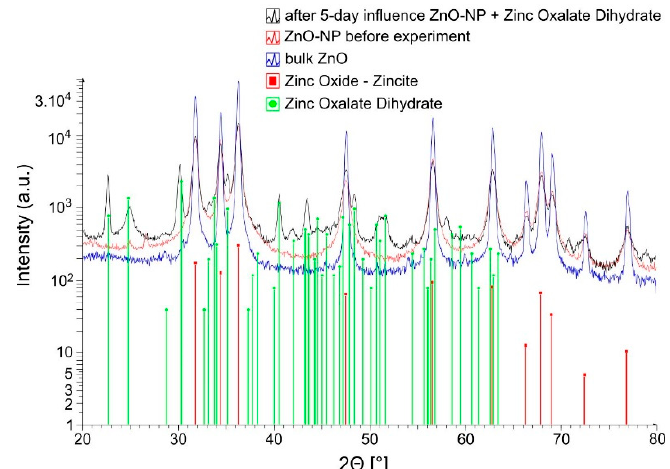
Figure 4. Diffractogram of the partially transformed ZnO NP to Zn oxalate dihydrate.